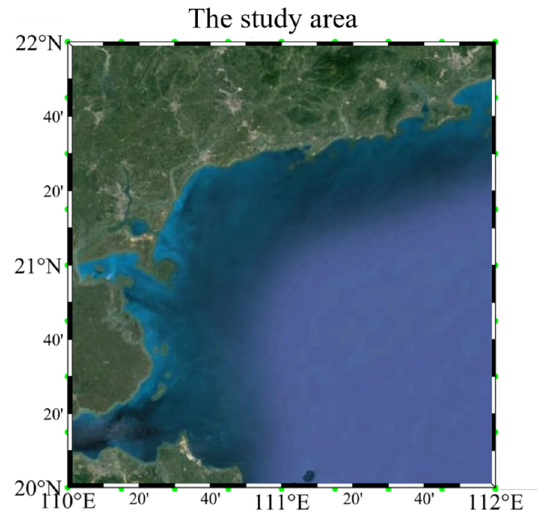
Figure 2. The study area of this research.